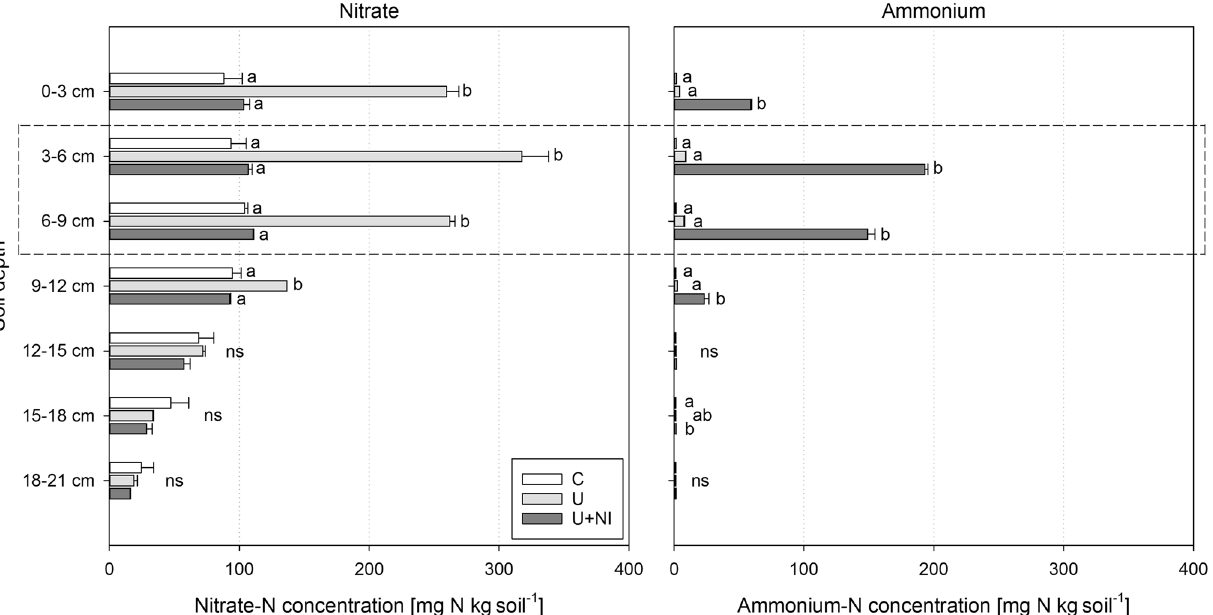
Figure 4. Depth distribution of readily available N and adsorbed N species NO 3 − (left) and NH 4 + (right) in unplanted soil columns (experiment 2) for the treatments control (“C”), urea (“U”) and urea with nitrification inhibitor (“U+NI”) on day 17, corresponding to 17 DAP in experiment 3. Significant differences between treatments within each layer ( p < 0.05) are indicated by different letters, ns = not significant. Dashed box indicates area of fertiliser placement. Error bars indicate standard error.